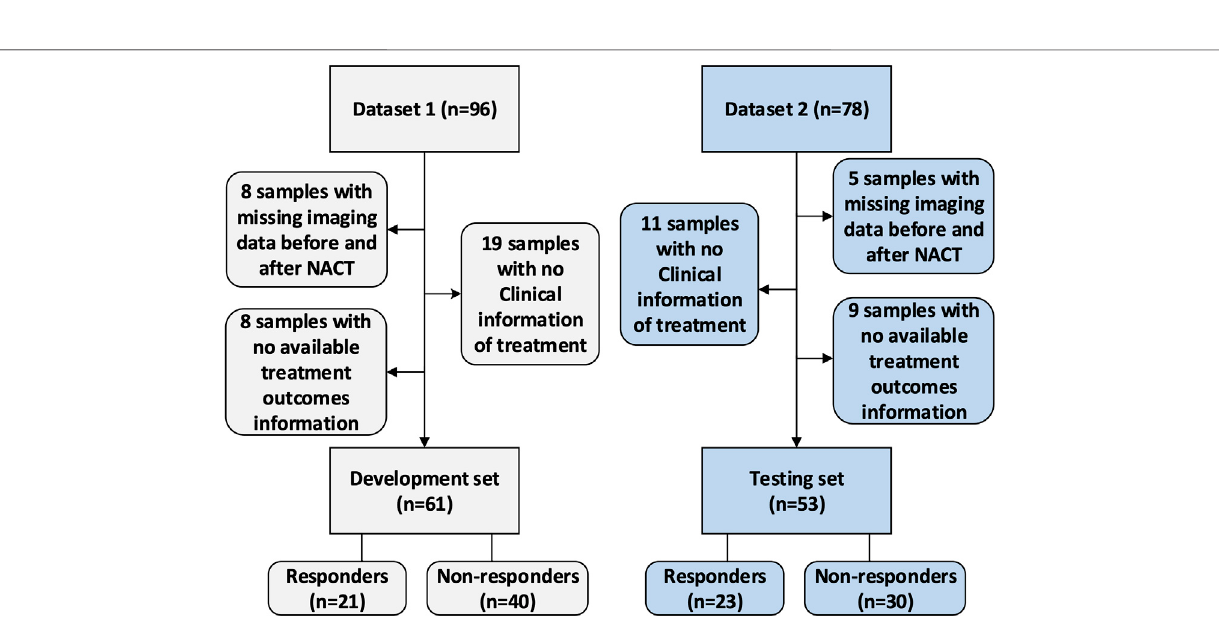
FIGURE 2 | Data selection